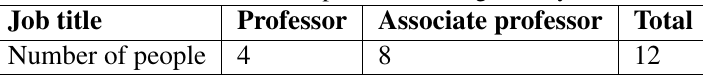
Table 2 Basic situation of experts conducting validity evaluation